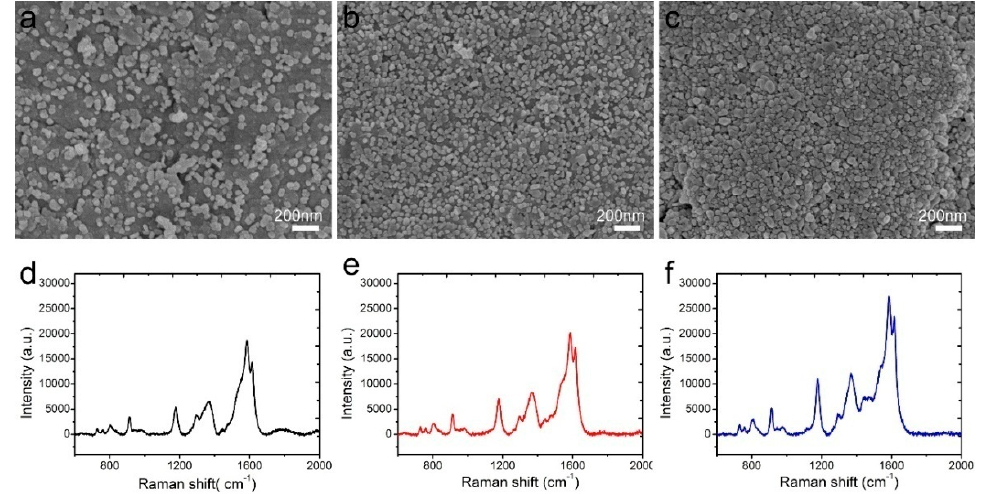
Figure 4. SEM images of NW@PDA fabrics after immersing in [Ag(NH 3 ) 2 ] + solution for ( a ) 4, ( b ) 8, and ( c ) 12 h. ( d – f ) Surface-enhanced Raman scattering (SERS) spectra of crystal violet (CV) collected on the 4, 8, and 12 h NW@PDA@AgNPs fabrics.